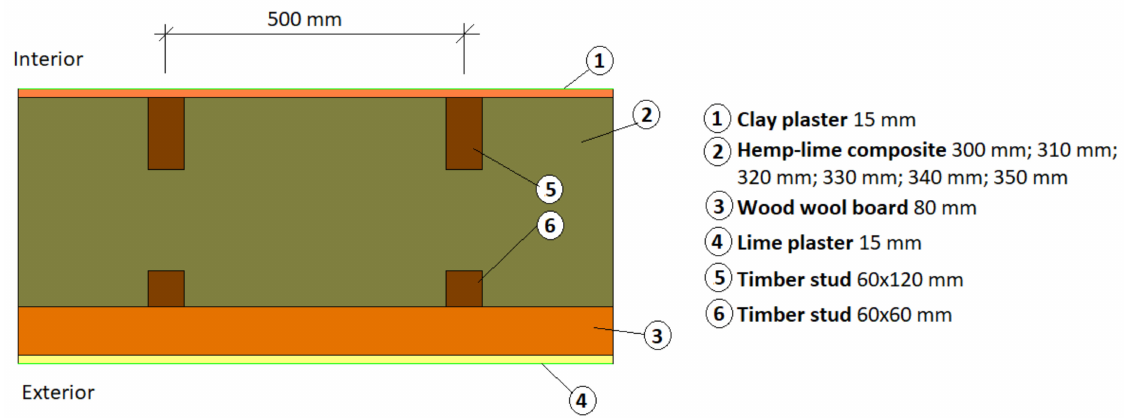
Figure 5. Model of external wall adopted in the simulation.